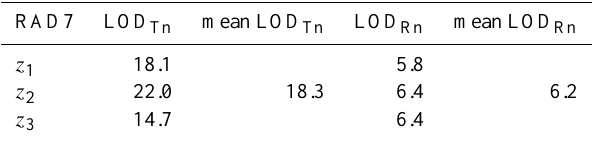
Fig. 7. Example of systematic and random error determination from side-by-side measurements. Left panel: determination of the sys- tematic error of the Tn concentration between the RAD7 at z 1 and z 2 using the bivariate weighted linear least-squares fitting regres- sion analysis by the Williamson–York method (Cantrell, 2008). Er- ror bars represent the uncertainties from counting statistics of the √ n) . Right panel: quantification of the random error RAD7 ( σ = ( σ1C) from the residuals around the fit (for details see Sect. 2.5 and Wolff et al., 2010). Table 2. Limit of detection (LOD in Bqm − 3 ) of the RAD7 mon- itors (with the system characteristics described in Sect. 2.2) deter- mined under field conditions during the zero air measurements.